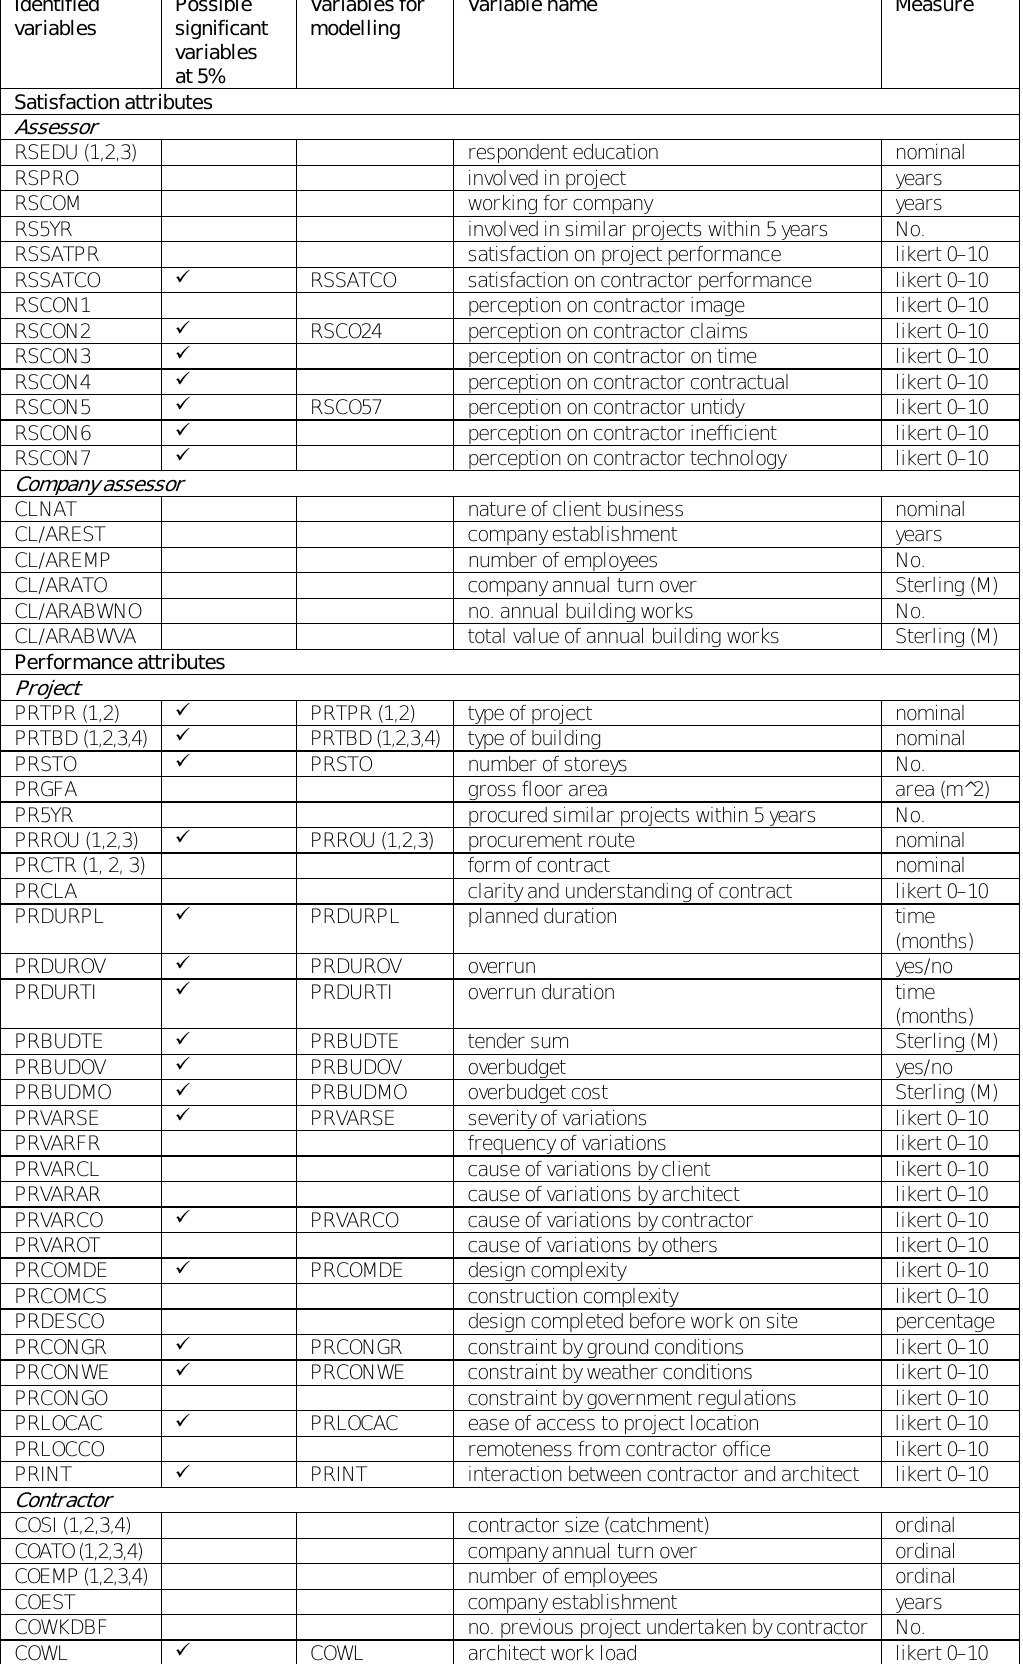
Table 1: List of independent variables of clients' assessment of contractor performance Identified